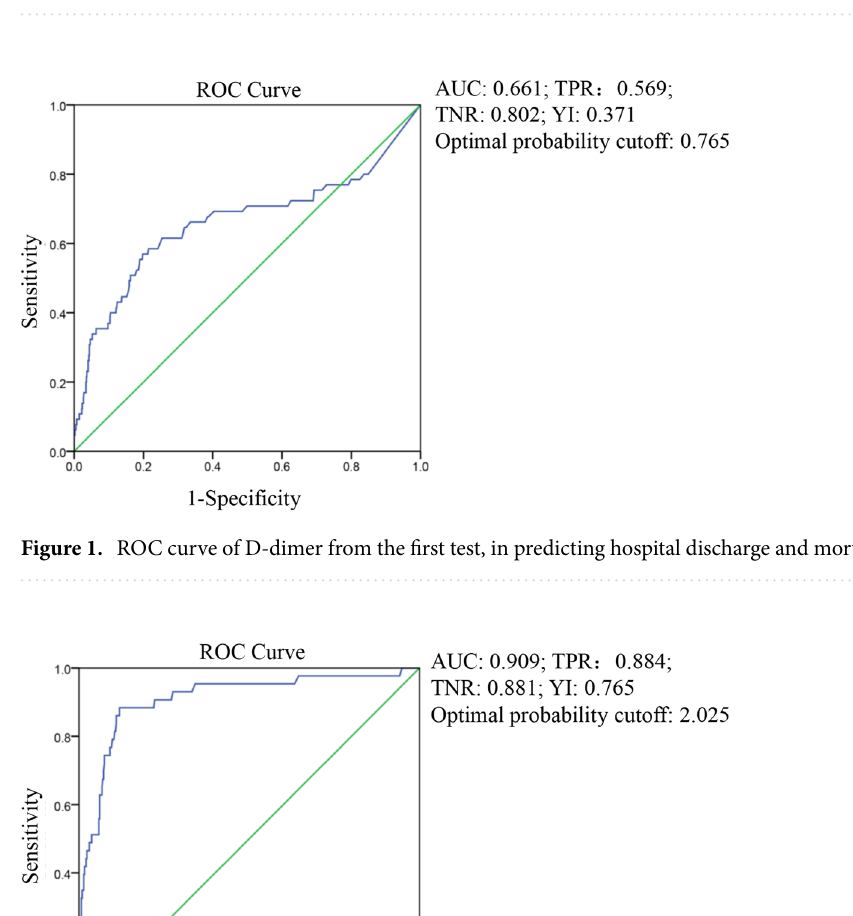
Table 4. Relationship between D-dimer levels and the progression of disease.